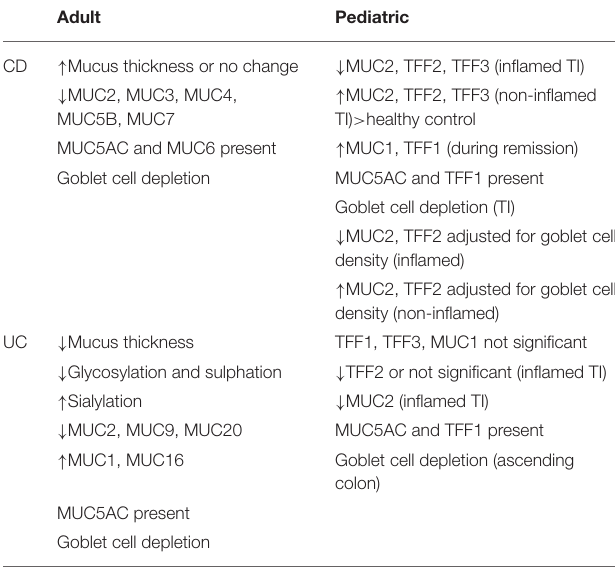
TABLE 1 | Characteristics of MUC and TFF expression in adults and pediatric IBD patients.